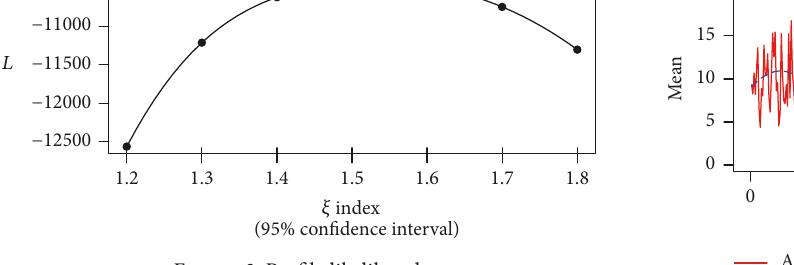
Figure 3: Profile likelihood.